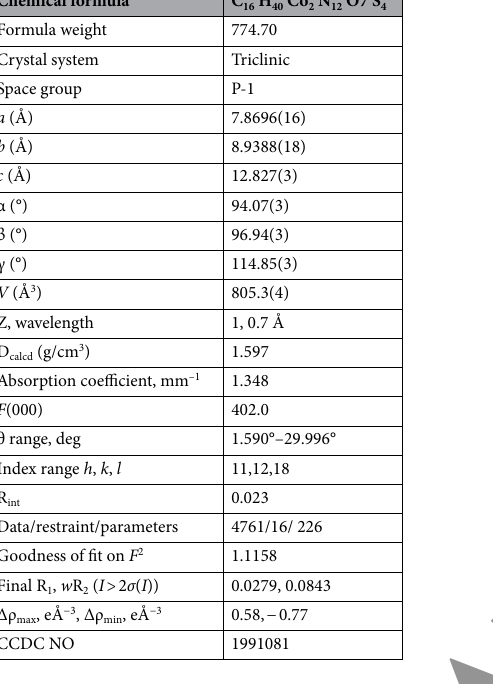
Table 3. Crystal data and structure refinement parameters of SC 1.